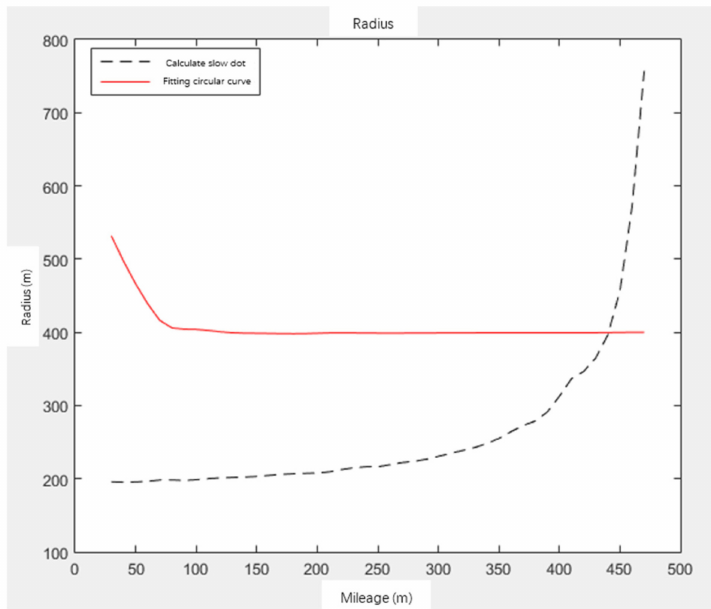
Figure 7. Fitting radius of circular curve R 1 and radius of HY point R 2 .